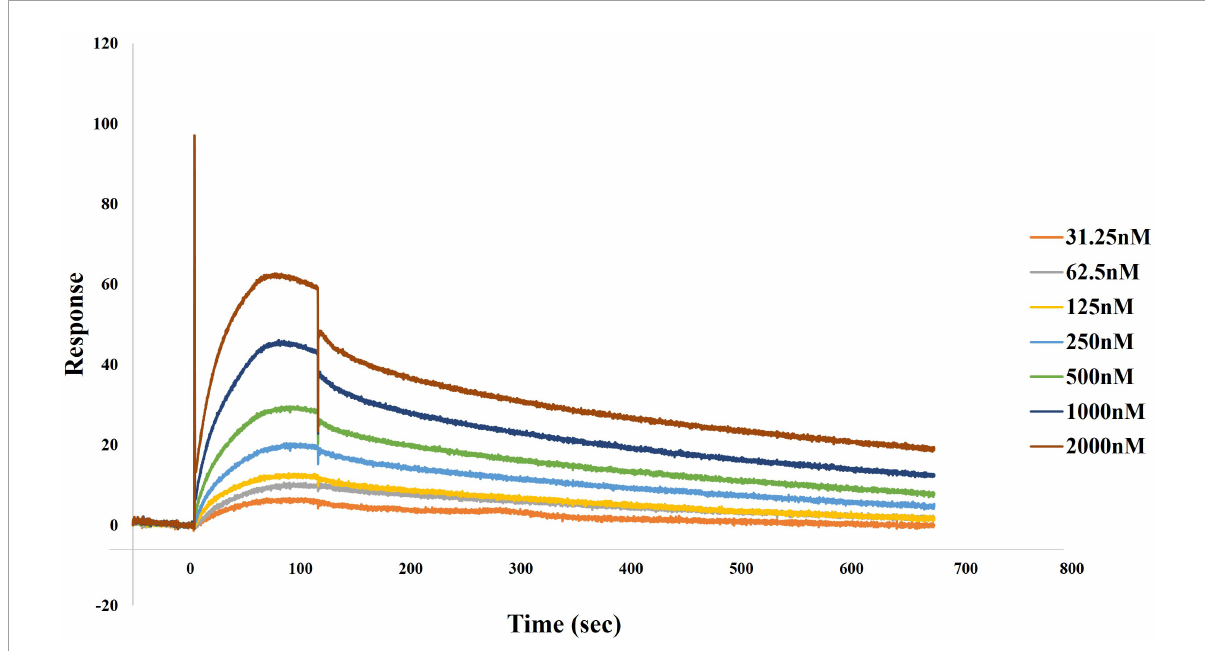
FIGURE4 Direct binding of DnaK to DnaK (self-binding) as determined by surface plasmon resonance (SPR). Association of DnaK at different concentrations on 2,274.9 response units of DnaK immobilized on a CM5 biosensor chip proceeded at a flow rate of 35 µ l/min for 120 s, followed by a 600 s-dissociation in HBS-EP. A preliminary kinetic analysis yielded a Kd value of 2.956e − 8